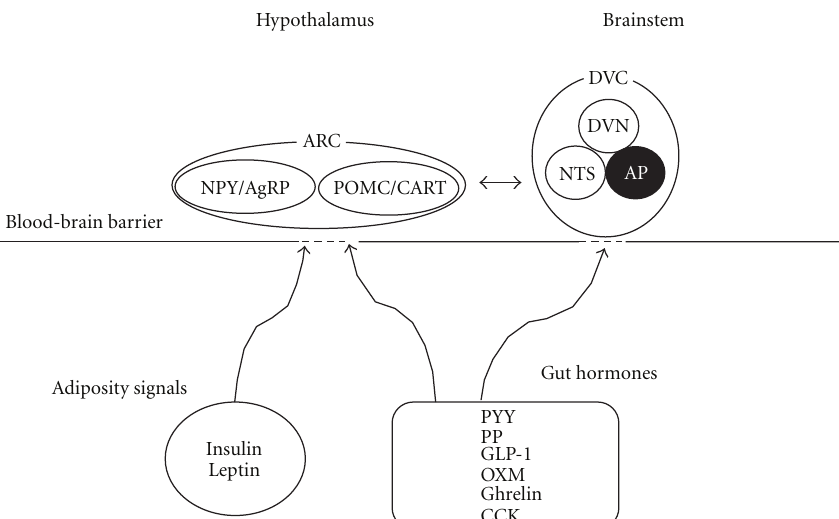
Figure 1: Humoral signals implicated in the physiological regulation of food intake. Diagram summarising the major signalling pathways which converge on the hypothalamus and brainstem in order to regulate food intake. ARC, arcuate nucleus; NPY/AgRP, neuropeptide Y and agouti-related peptide; POMC/CART, proopiomelanocortin and cocaine- and amphetamine-regulated transcript; DVC, dorsal vagal complex; DVN, the dorsal motor nucleus of vagus; NTS, the nucleus of the tractus solitarius; AP, area postrema; GLP-1, glucagon-like peptide-1; CCK, cholecystokinin; PP, pancreatic polypeptide; PYY, peptide YY; OXM,